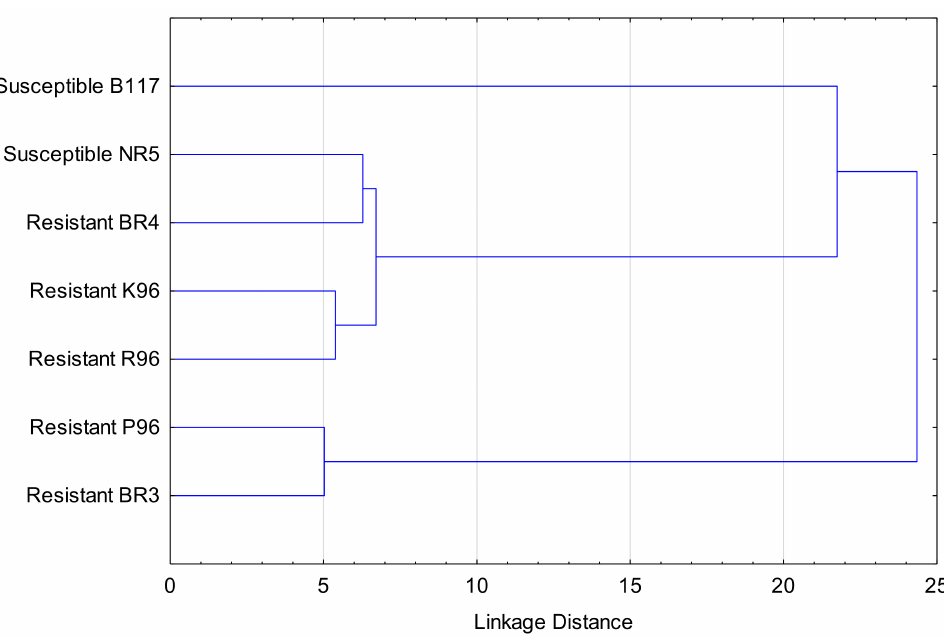
Figure 8. Cluster analysis for the sunflower varieties studied based on the concentration of the analyzed compounds (costunolide, dehydrocostuslactone, heliolactone, orobanchyl acetate, and